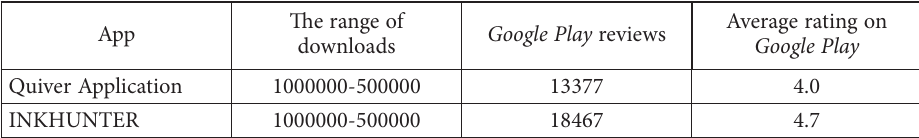
Table 2. Quiver Application and INKHUNTER application summary (source: created by the authors)